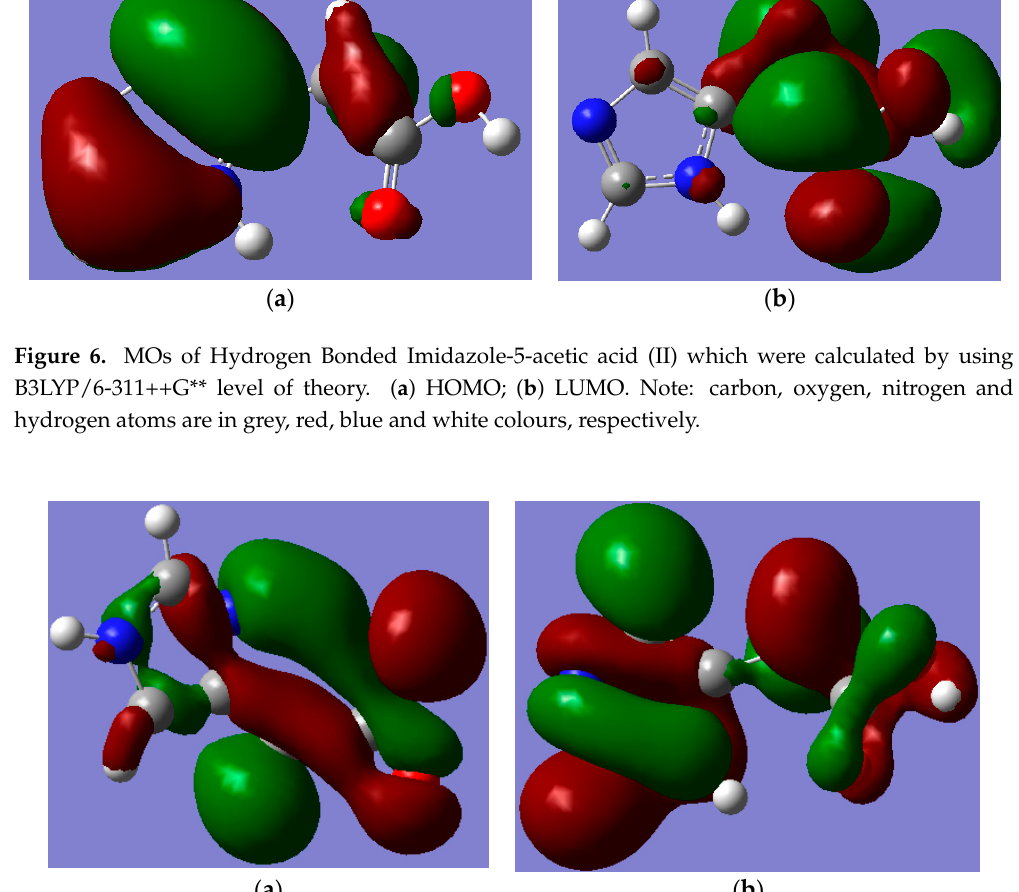
Figure 7. The pictorial visualization of HOMO-5 showing the Hydrogen bonding between the lone pair of the trigonal nitrogen atom of the imidazole ring in ( a ) (I) and its absence in ( b ) (II). Note: carbon, oxygen, nitrogen and hydrogen atoms are in grey, red, blue and white colours, respectively.